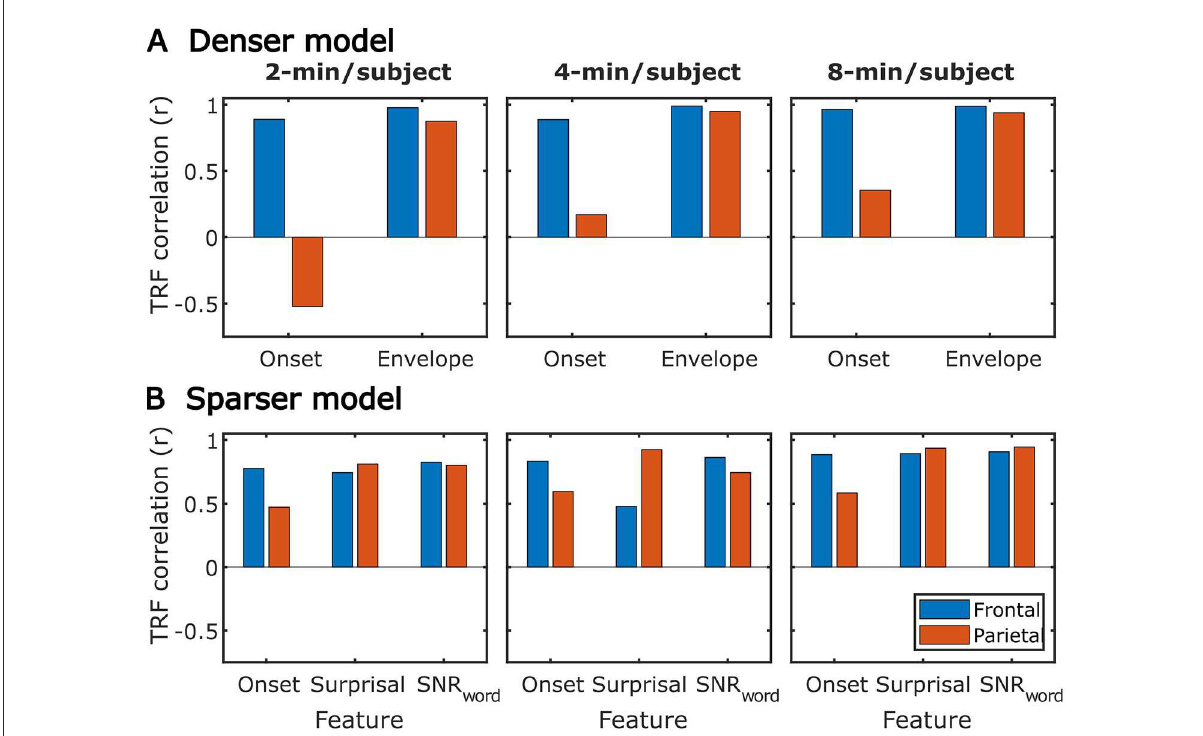
FIGURE15 Similarity between average TRFs derived using subject-specific and generic analyses for features in the sparser (A) and denser (B) models. For generic analyses, both the results from analyses utilizing 2-min (left column), 4-min (middle column), and 8-min (right column) per subject are shown. Different bar colors represent the frontal and parietal ROIs (see legend in lower left plot). Note that these analyses utilized TRFs derived using models trained on largest amounts of data in each type of analysis, i.e., most data per subject for subject-specific analyses, and most subjects for generic